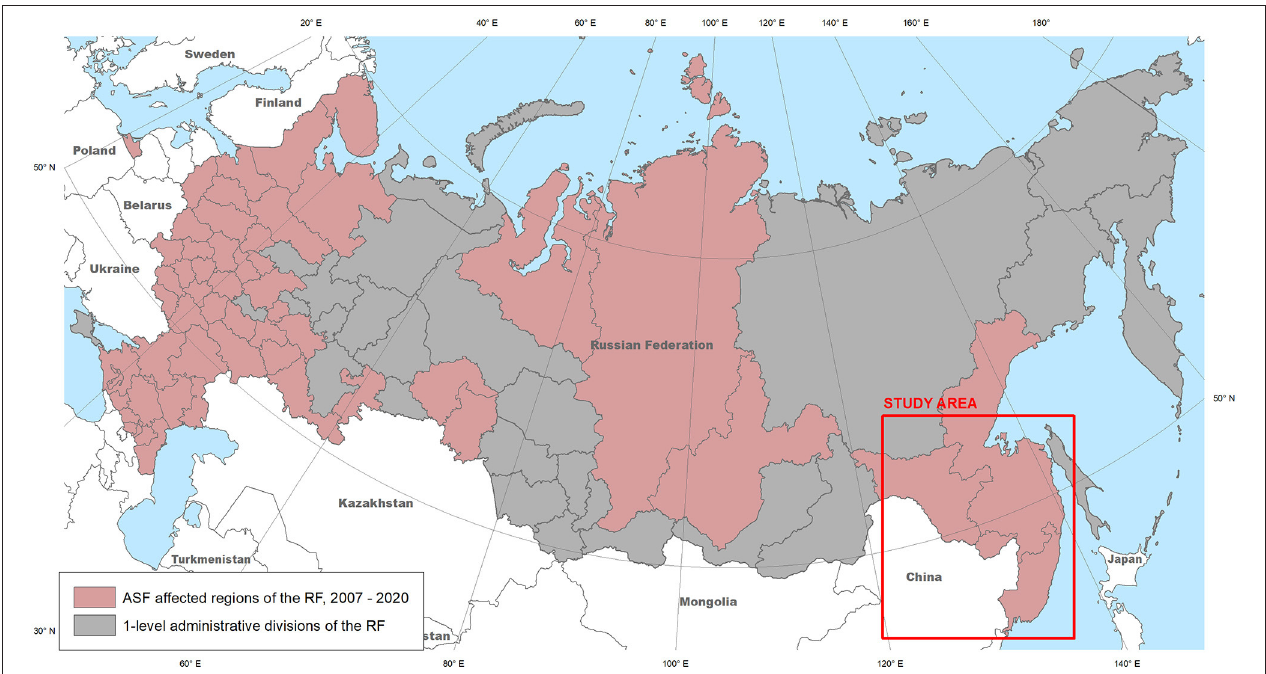
FIGURE 1 | The ASF-affected regions of the Russian Federation, 2007–2020 (source: OIE), and the study area.